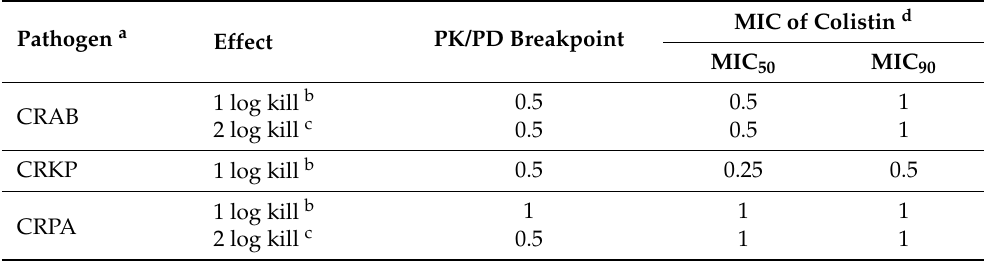
Table 3. Comparison of PK/PD breakpoints and MICs of colistin against carbapenem-resistant Gram-negative